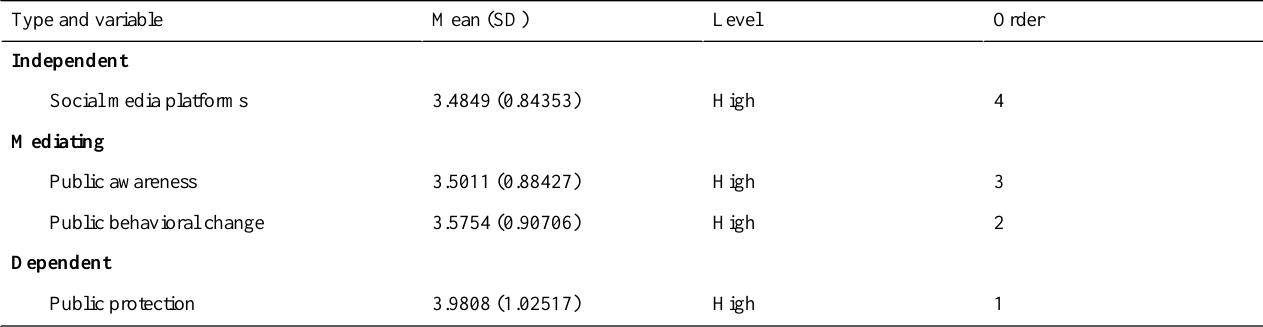
Table 4. Overall means, SDs, levels, and orders of the study